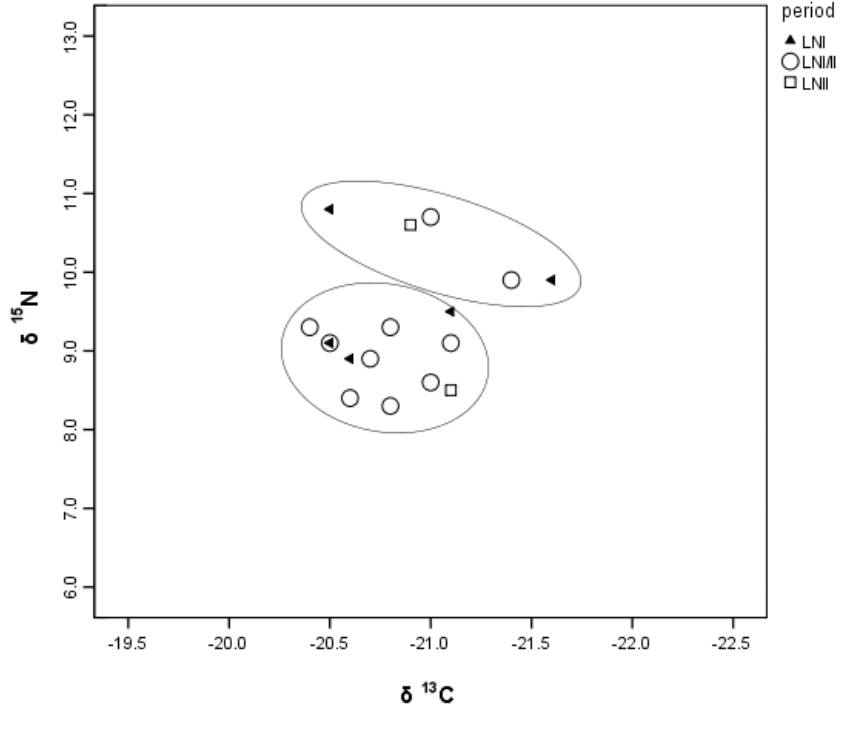
Figure 9. δ 13 C and δ 15 N values in collagen from the 17 sampled teeth from Falköping stad 5, included in the diet investigation. LNI: Late Neolithic I, LNII: Late Neolithic